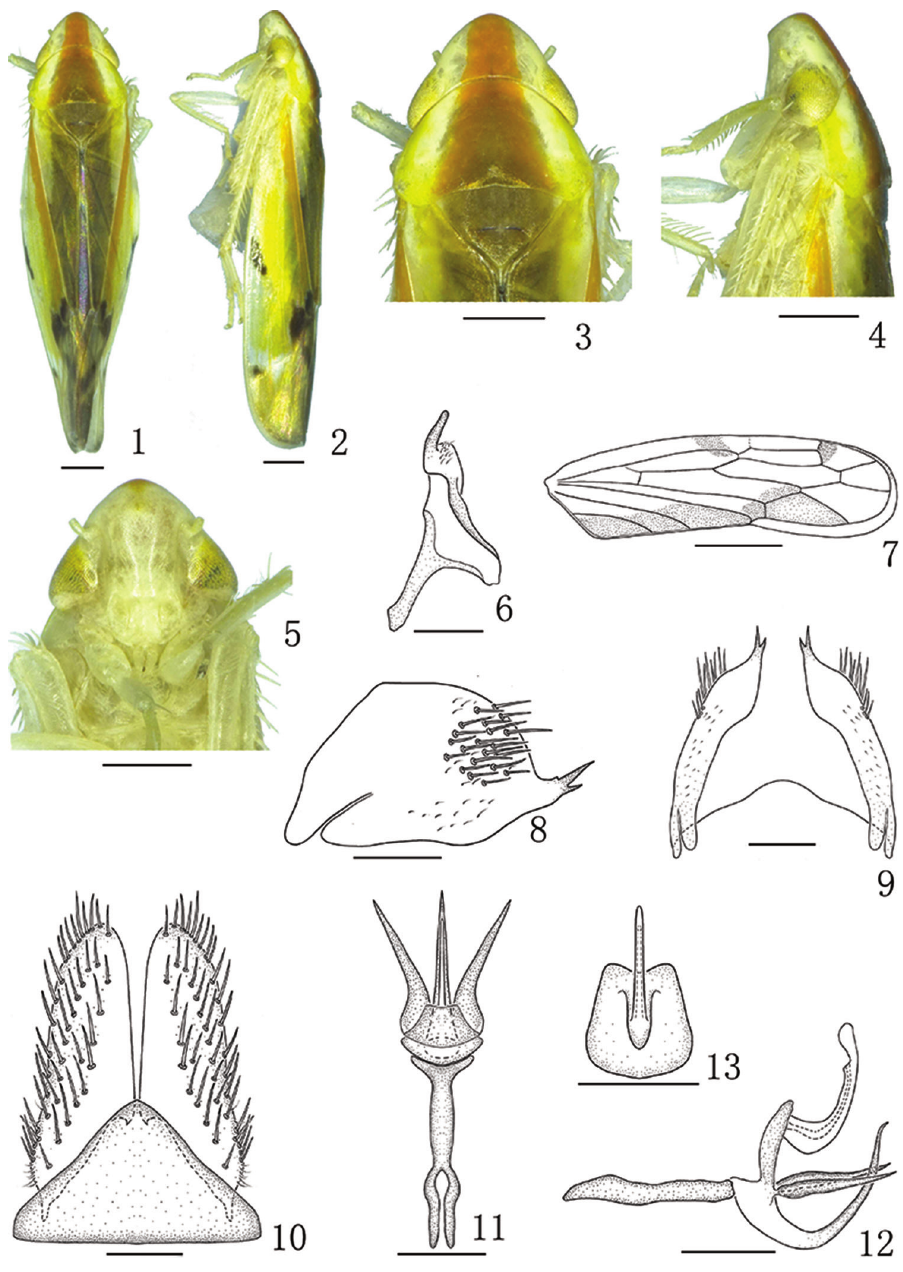
Figures 1–13. Neomohunia longispina sp. n., male 1 Male habitus, dorsal view 2 Male habitus, lateral view 3 Head and thorax, dorsal view 4 Head and thorax, lateral view 5 Face 6 Style, dorsal view 7 Fore- wing 8 Male pygofer, lateral view 9 Male pygofer, ventral view 10 Valve and subgenital plate, ventral view 11 Connective and aedeagus, dorsal view 12 Connective and aedeagus, lateral view 13 Shaft and preatrium, caudal view. Scale bars: 0.5 mm ( 1–5, 7 ); 0.2 mm ( 6, 8–13